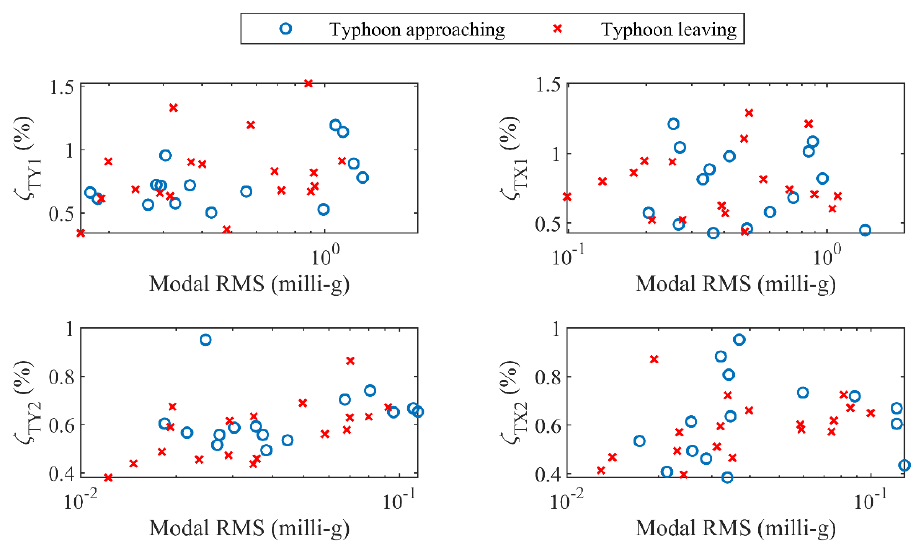
Figure 15. Relationship between damping ratio and modal RMS.